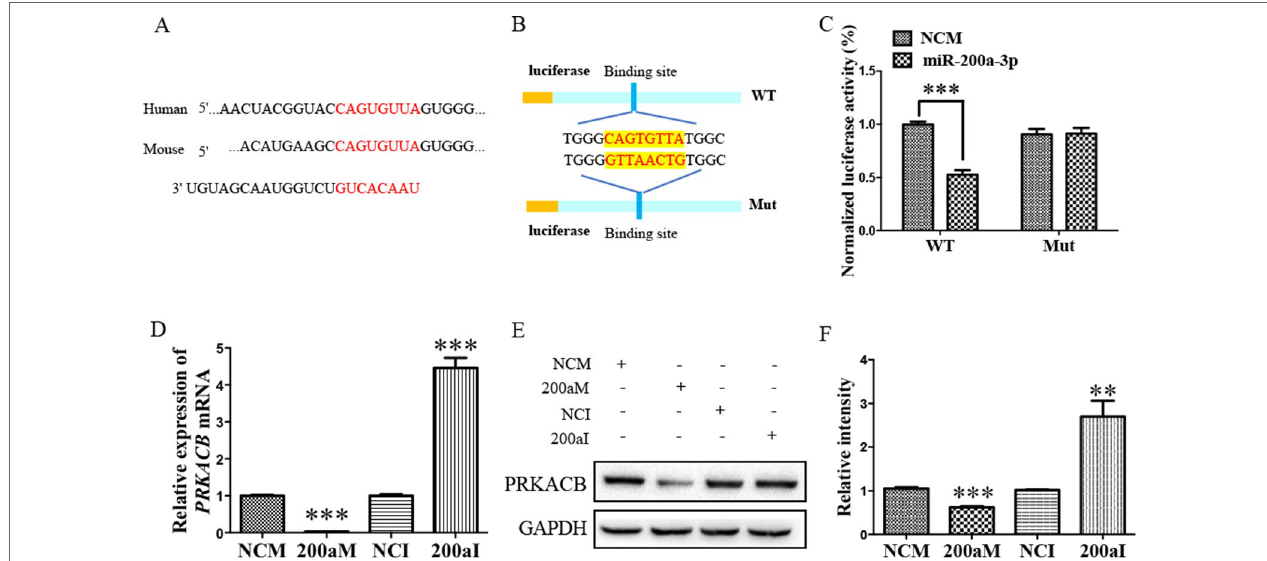
FIGURE 4 | The PRKACB is another target of miR-200a-3p. (A) Bioinformatic analysis indicating the binding site of miR-200a-3p with the 3’-UTR of PRKACB mRNA. (B) Design of the recombinant Luc- PRKACB -MUT (mutant) and Luc- PRKACB -WT (wild-type) construction. (C) Changes in the relative luciferase activity in each group after plasmids transfection. miRNA-200a-3p mimics caused significant inhibition of reporter luciferase activity in the construct with a wild-type (WT) PRKACB 3’-UTR in contrast to the mutant (Mut) PRKACB 3’-UTR in HEK293 cells ( n = 4). (D) Quantification of PRKACB mRNA levels after transfection with miRNA-200a-3p mimics (200aM), miRNA-200a-3p inhibitors (200aI), and corresponding negative controls (NCM/NCI) (n = 3). (E , F) The expression of the PRKACB protein significantly decreases and increases after miRNA-200a-3p mimics (200aM) and inhibitor (200aI) transfection, respectively, relative to the corresponding negative controls (NCM/NCI), as demonstrated here by representative images (E) and quantitative analysis (F) by Western blotting ( n = 3). Data are shown as the mean ± SEM. * P < 0.05, ** P < 0.01, *** P < 0.001 versus relevant